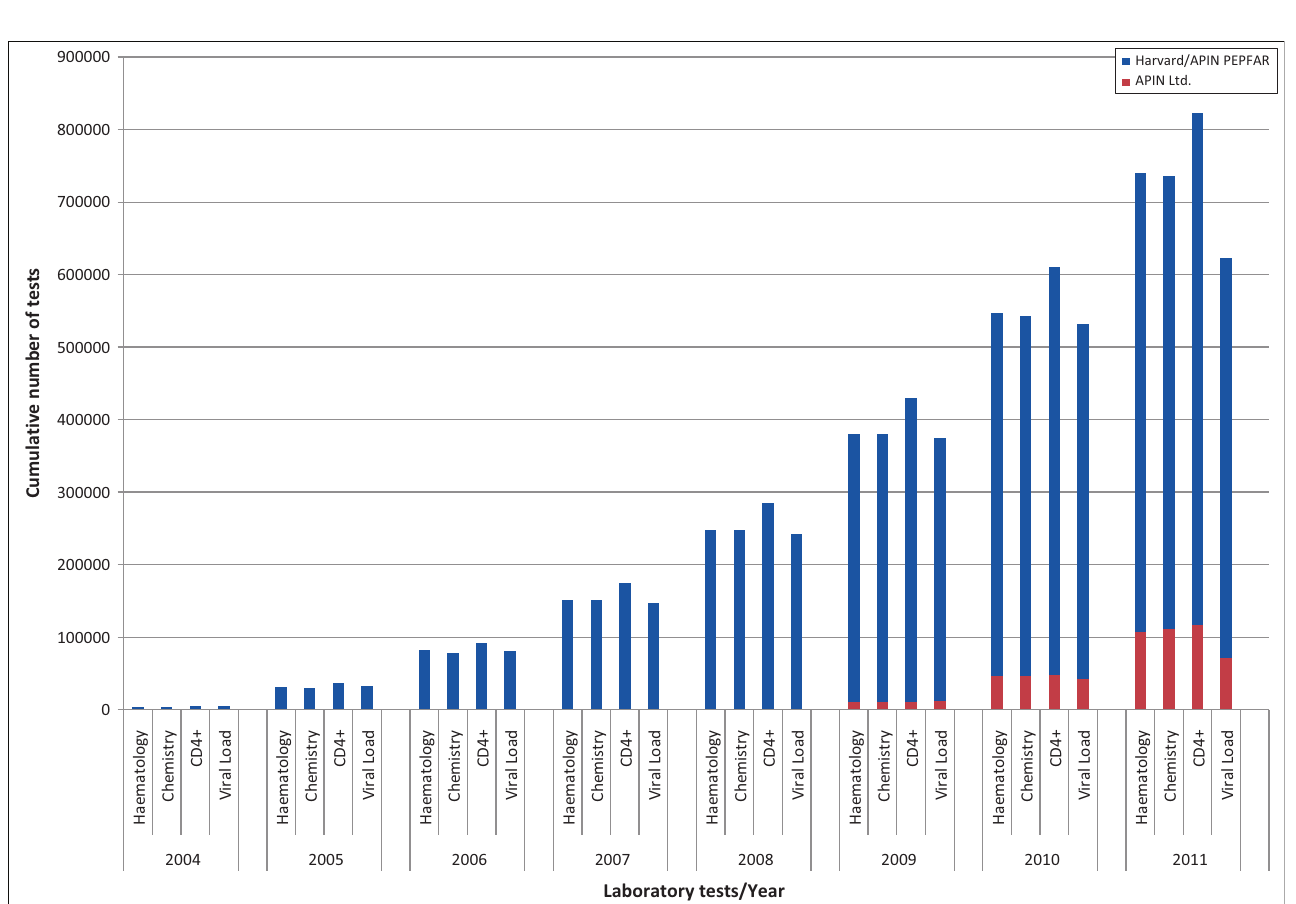
FIGURE 4: Cumulative laboratory tests performed by Harvard/APIN PEPFAR laboratories.